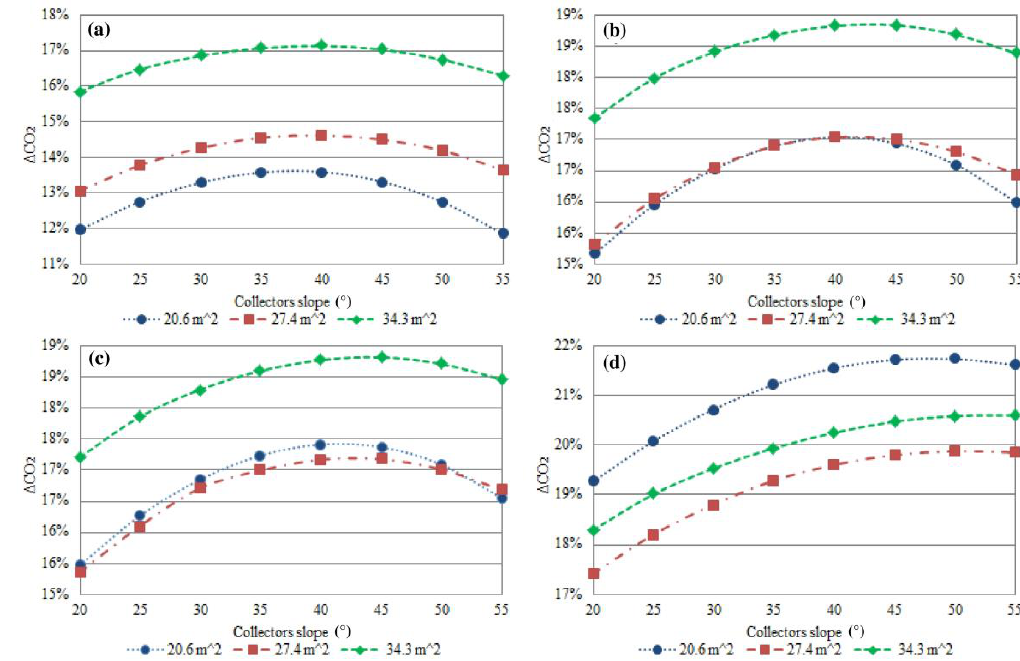
Figure 15. Equivalent CO 2 avoided emissions of the ASs with 0% of solar thermal energy surplus used and with evacuated tube collectors in the four alternative configurations: ( a ) Scenario A; ( b ) Scenario B; ( c ) Scenario C; and ( d ) Scenario D.